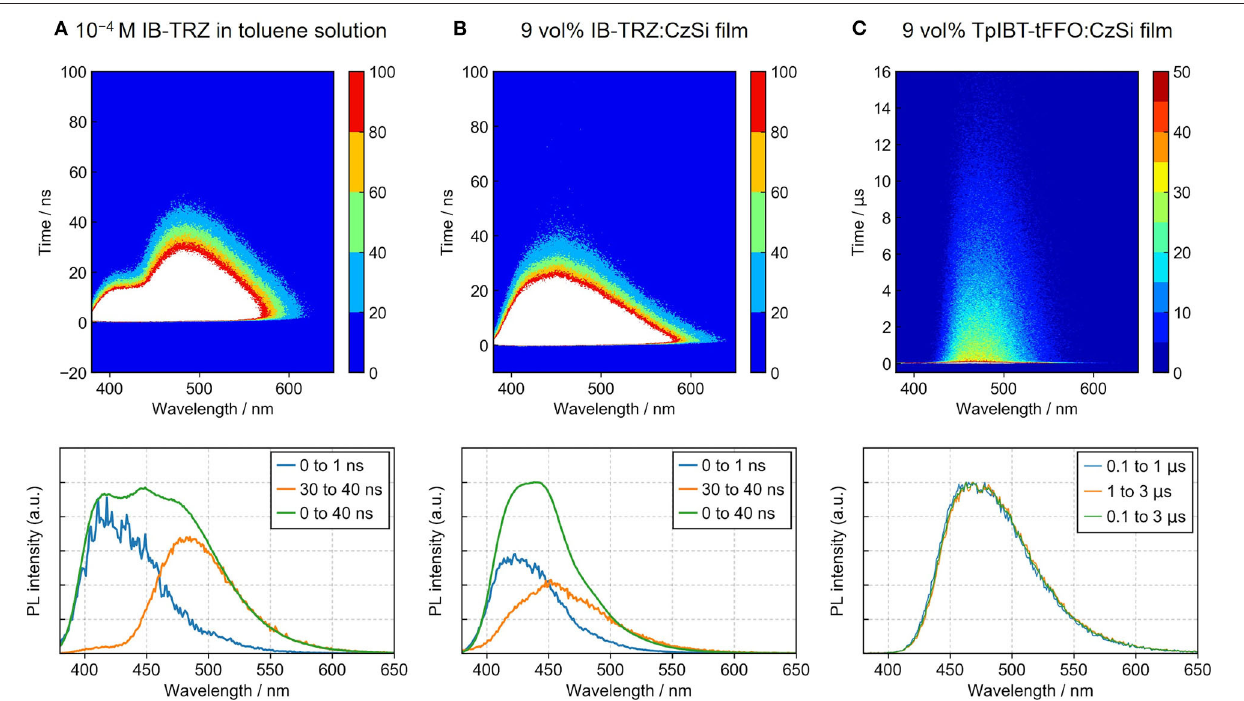
FIGURE 5 | Time-dependent PL measurements of (A) IB-TRZ in a toluene solution, (B) 9 vol% IB-TRZ:CzSi film, and (C) 9 vol% TpIBT-tFFO:CzSi film. Contour plots of the PL spectra as a function of time (top) and time-dependent PL spectra (bottom) are provided.